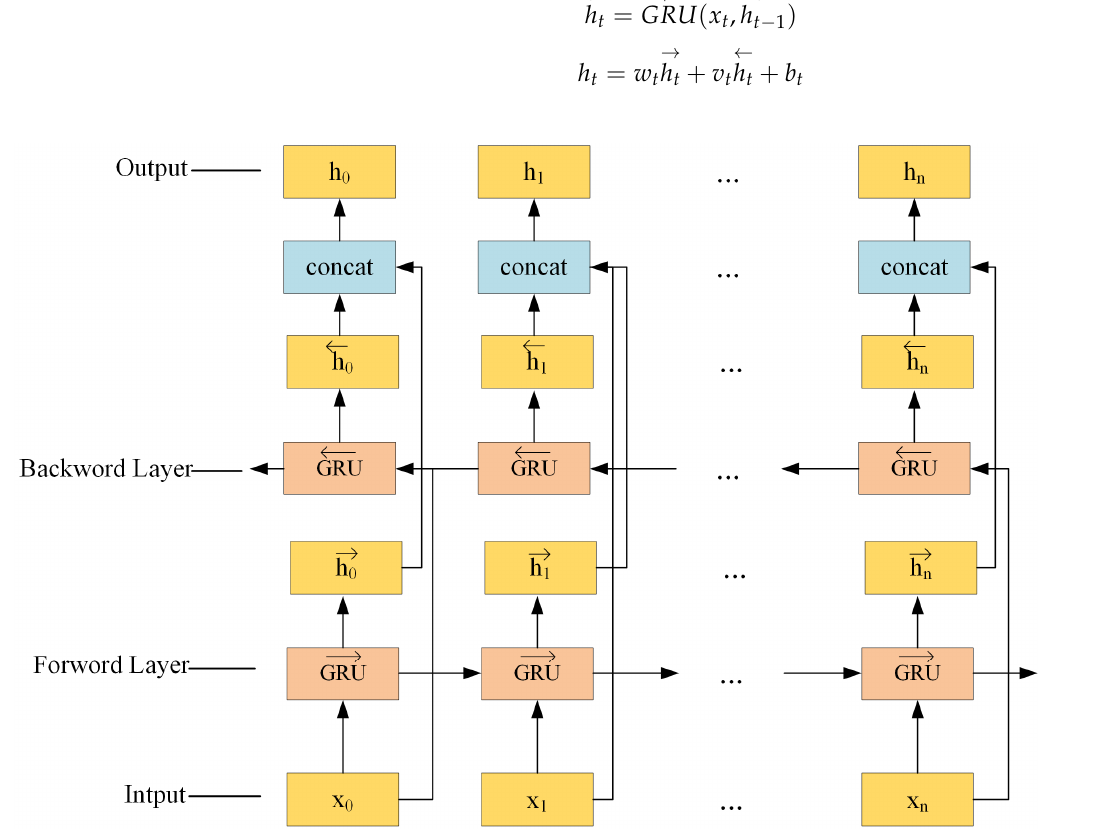
Figure 6. Structural overview of the bidirectional GRU network.